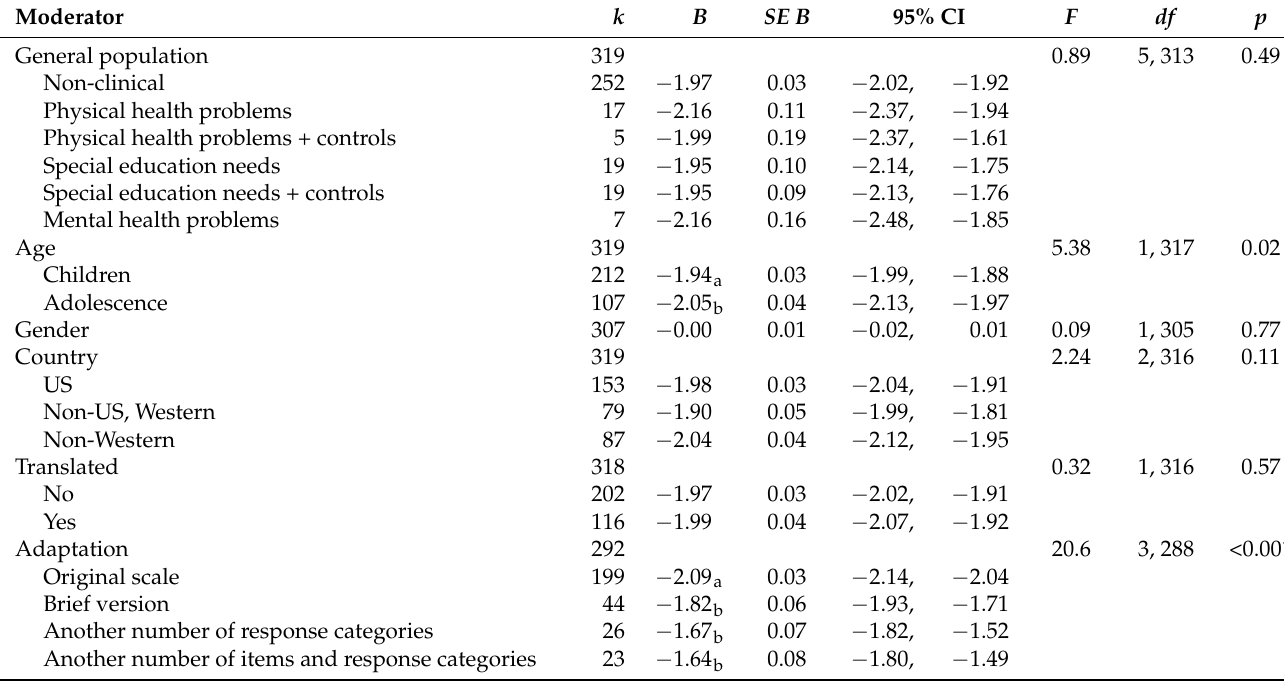
Table A1. Separate Regression Analyses for the Moderators Predicting Reliability Scores of the Children’s Loneliness Scale